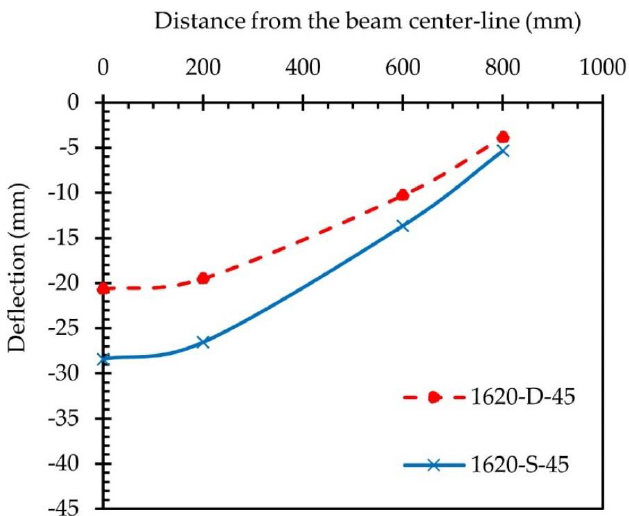
Figure 16. Deflection profiles along the spans of 1620-S-45 and 1620-D-45 at 380 kN.